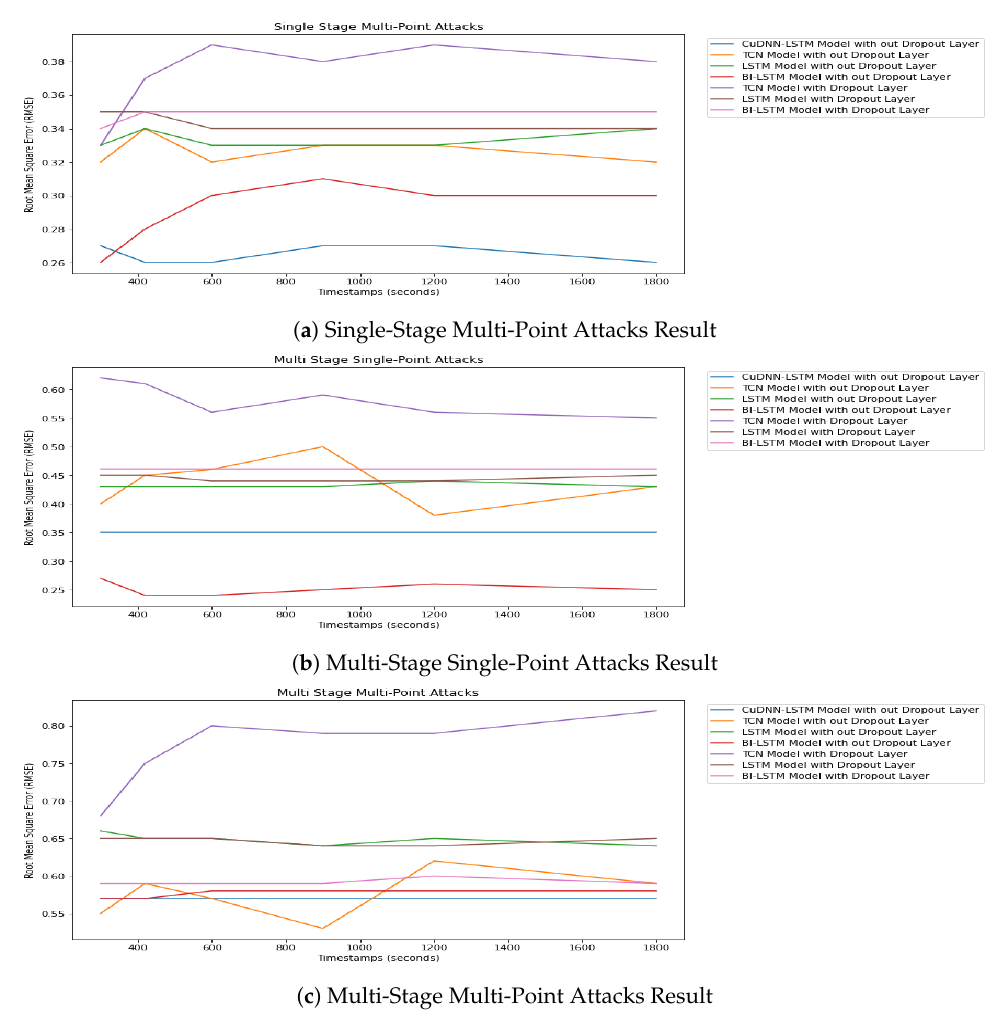
Figure 7. Single-Stage Multi-Point Attacks, Multi-Stage Single-Point Attacks and Multi-Stage Multi- Point Attacks